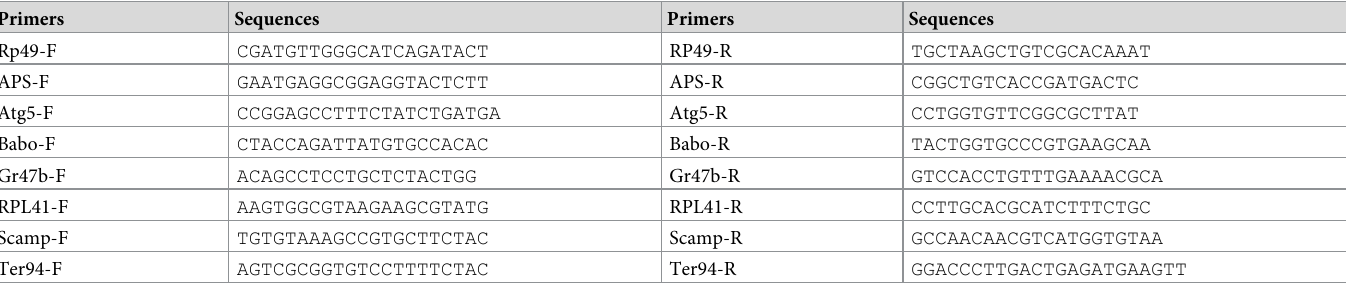
Table 1. Primer sequences for